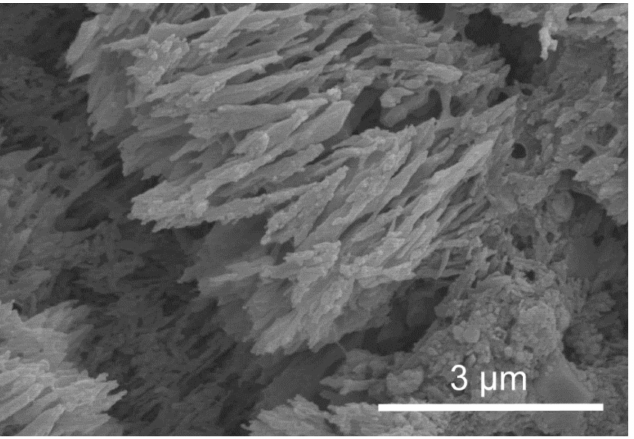
Figure 8. Longitudinal section through the tube of Dodecaceria caulleryi . Spherulitic prismatic